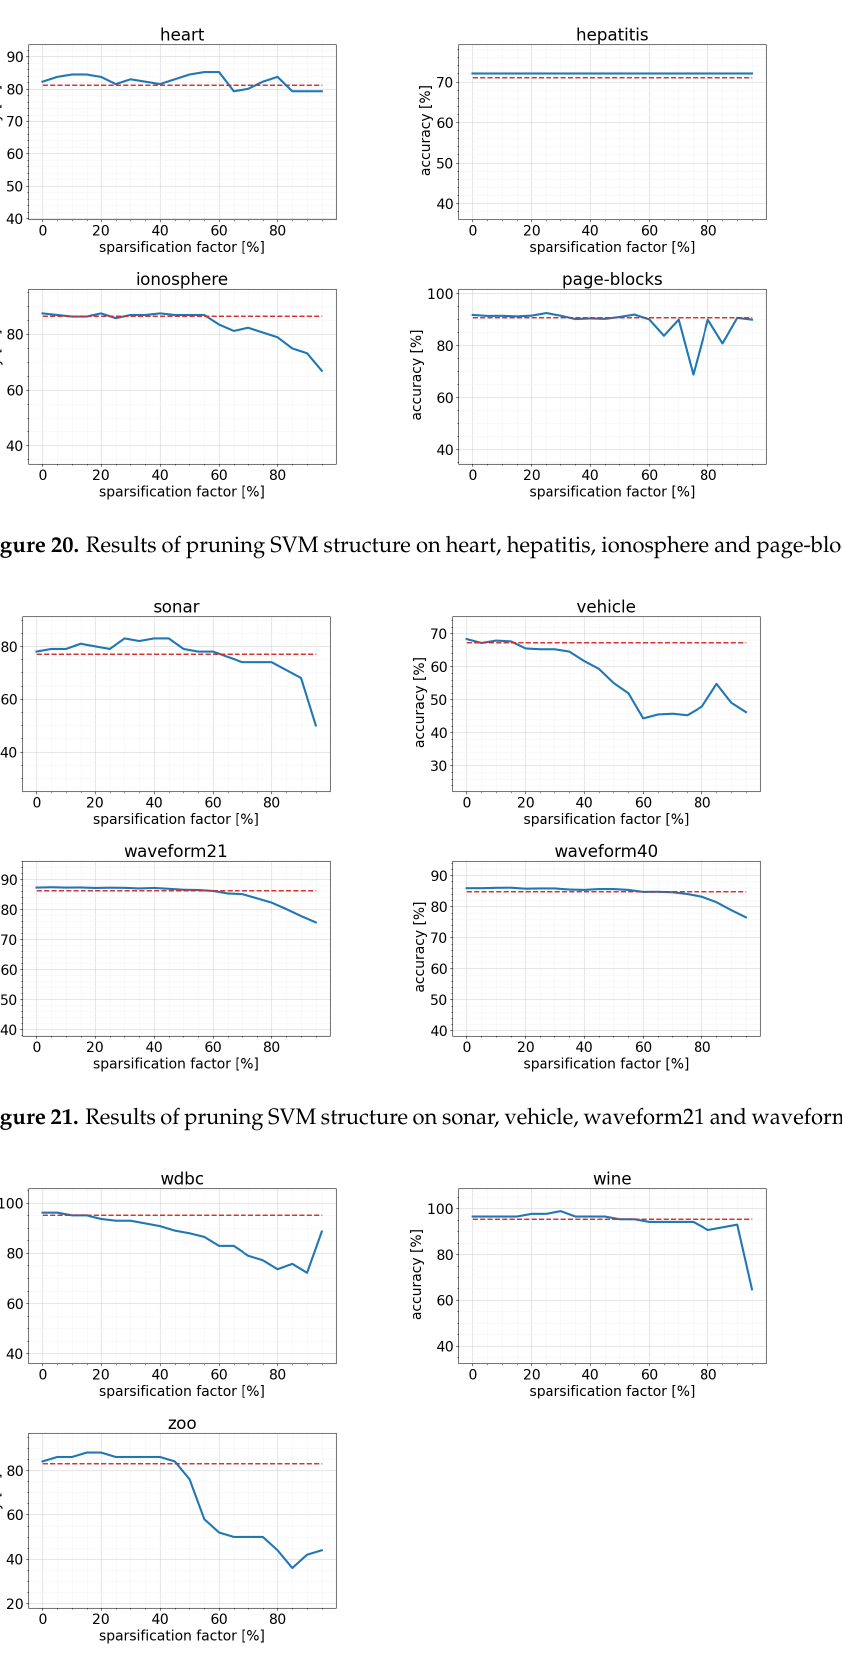
Figure 22. Results of pruning SVM structure on wdbc, wine and zoo